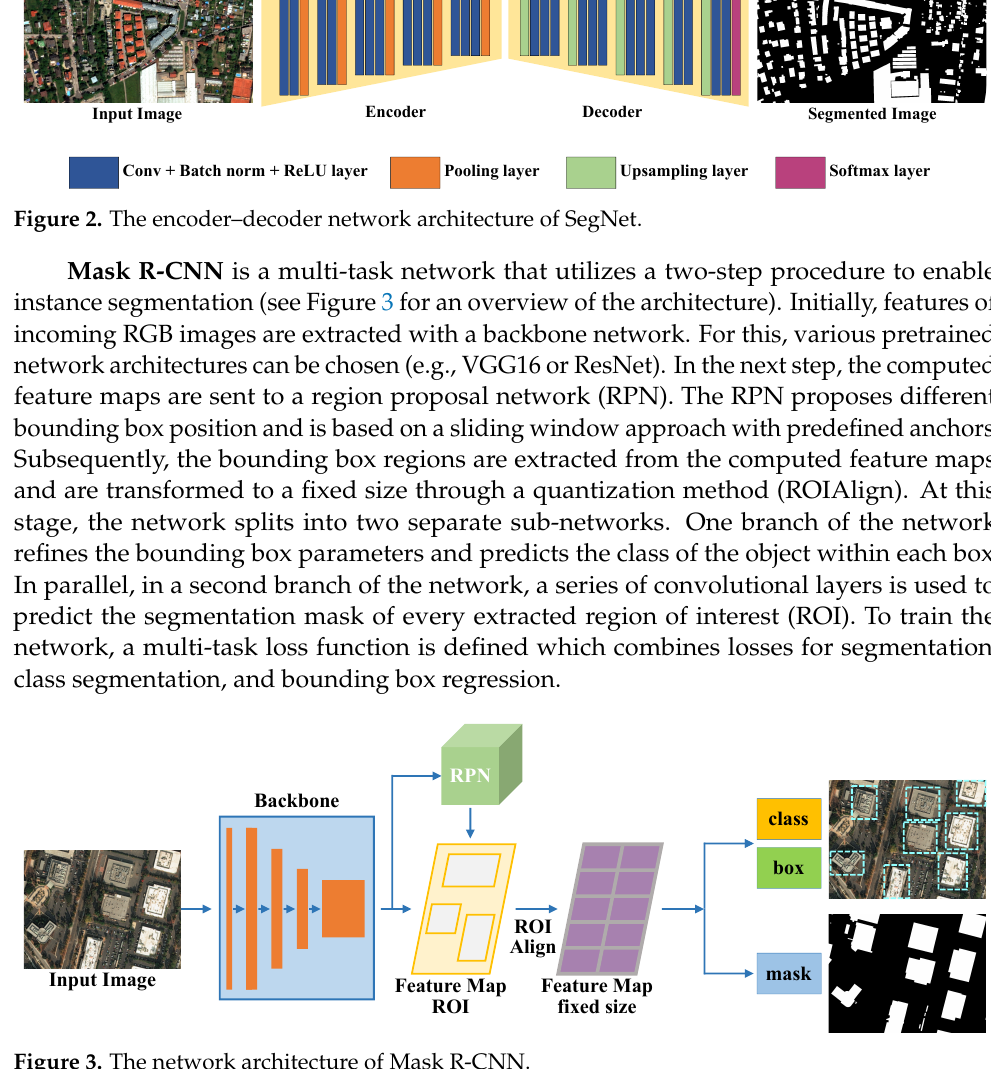
Figure 3. The network architecture of Mask